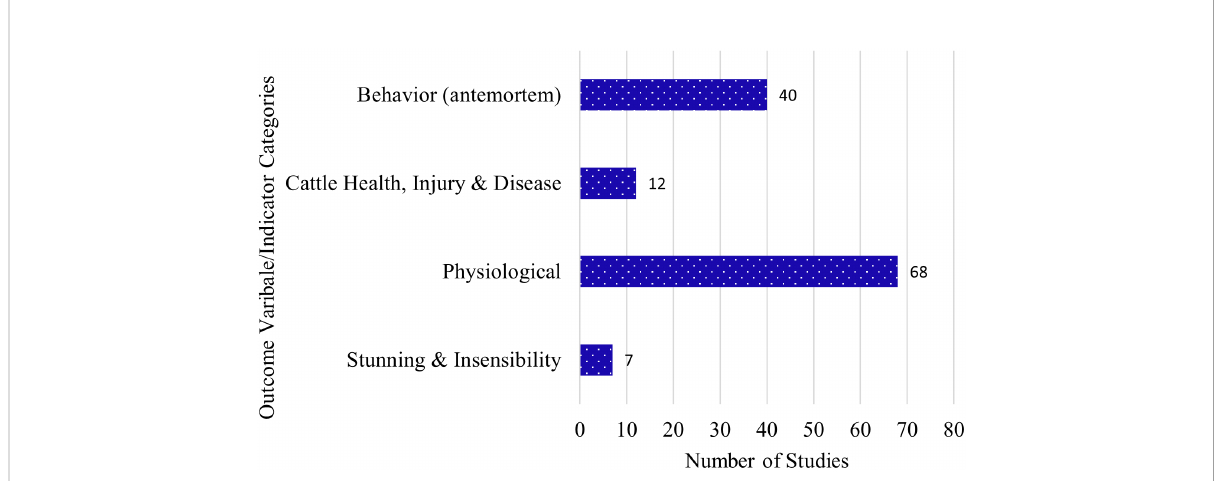
FIGURE 4 Number of studies per each outcome category included in the fi nal scoping review analysis out of the total collection ( n = 69 1 ). 1 Several studies reported multiple outcomes within each category, therefore the total number of variables reported in each category represent more than total studies included in the